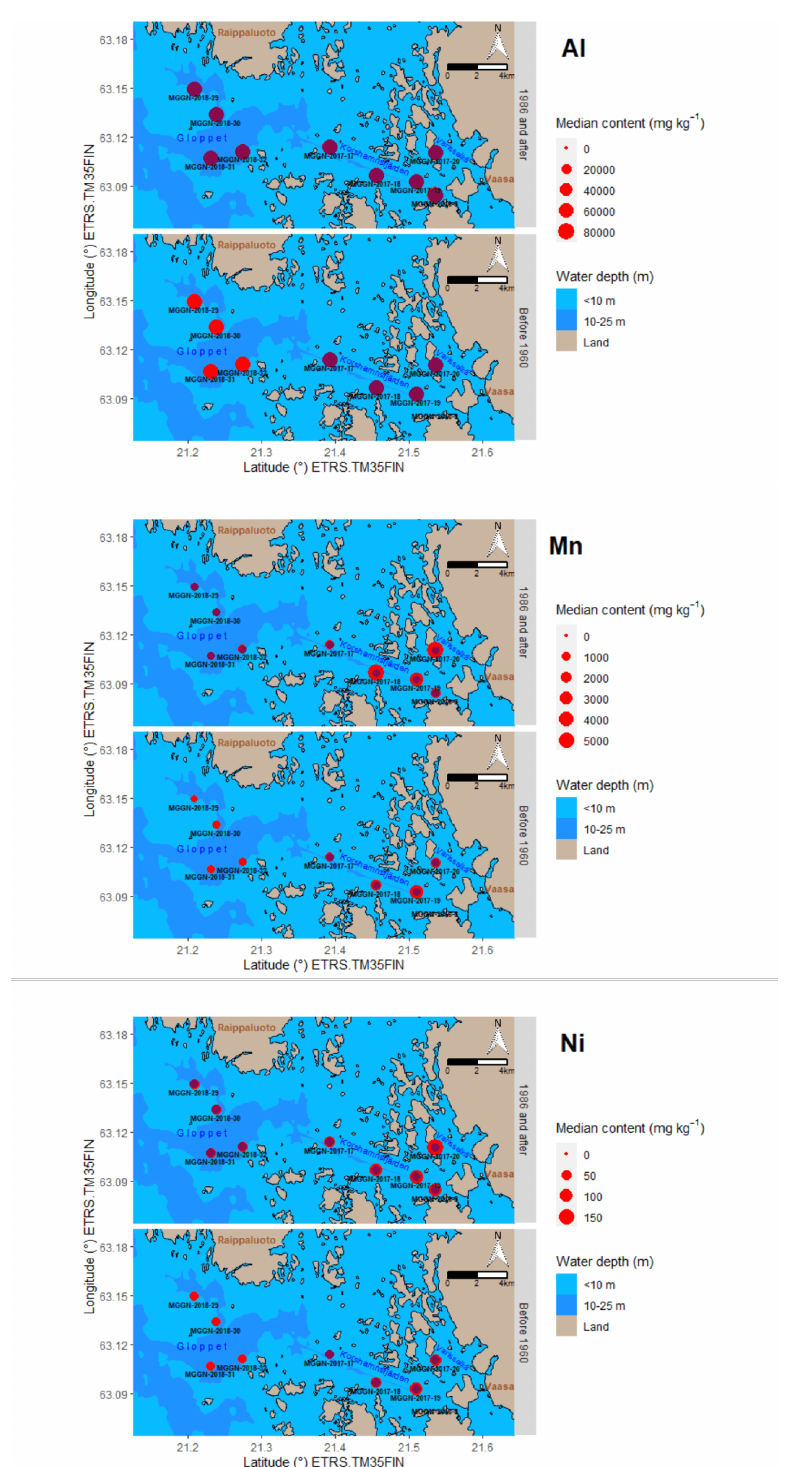
Figure 5. Maps of the sea area off the town of Vaasa, with the median Al, Mn, and Ni contents in the < 63µm grain size fraction of core sections deposited before 1960 (lower panels) and in 1986 and after (upper panels) indicated. Bright red dots indicate median contents, whereas the dark red dots indicate mean median contents in the pre-1960 sections of four cores from the Gloppet area (MGGN-2018-29, MGGN-2018-30, MGGN-2018-31, and MGGN-2018-32) in order to highlight the magnitude of enrichment. Note that core MGGN-2016-8 does not contain sediments deposited before 1960. The Laihianjoki and Sulvanjoki rivers are outside the map area, in the southeastern corner. Source: nautical chart – Finnish Transport Agency,